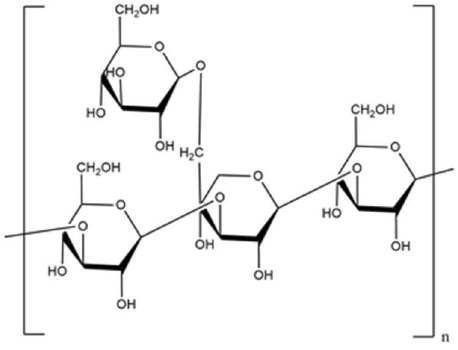
Figure 3. The chemical structure of sleroglucan.